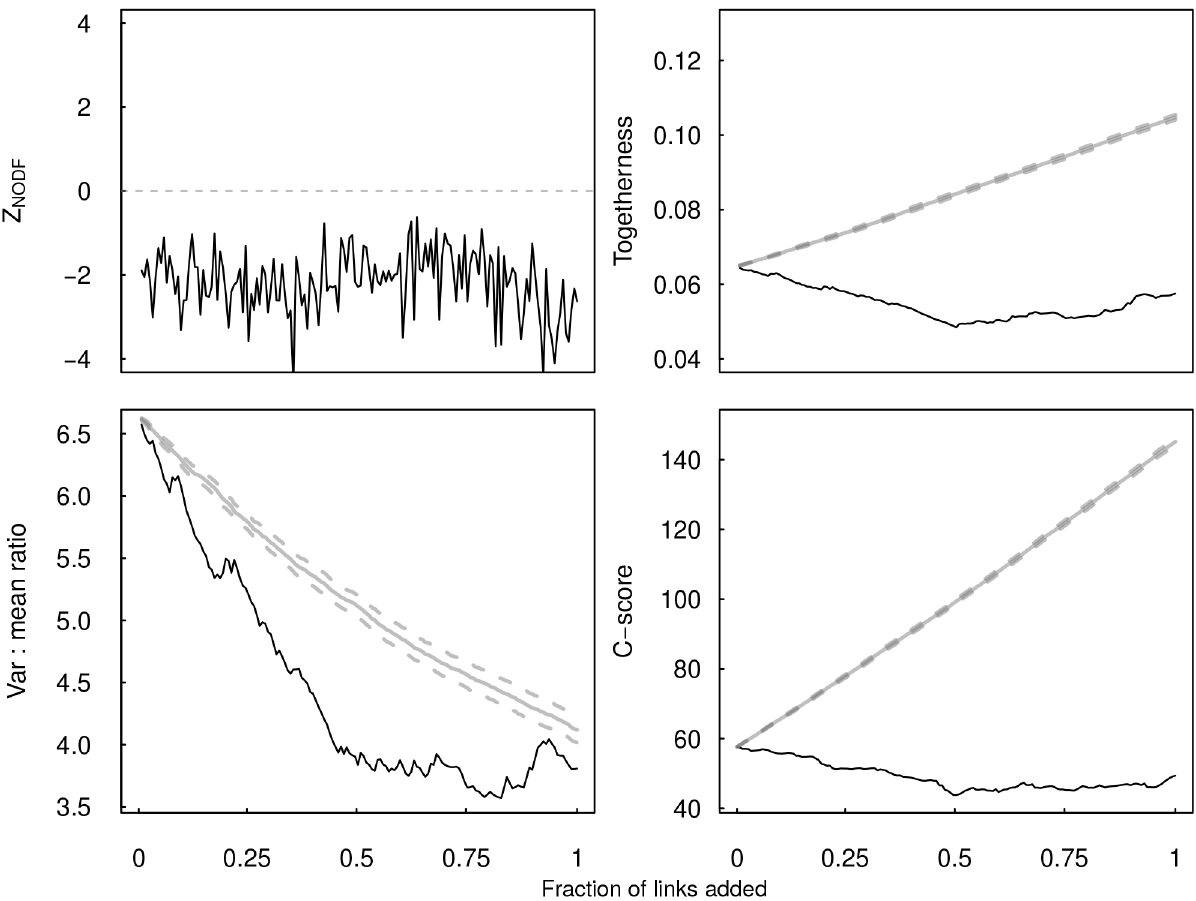
Fig 3. The sequential addition of the most likely missing links resulted in changes to severalnetwork properties relative to the change expected under random link addition (grey lines and dashed 95% confidence intervals). Specifically, the ability to detect nestedness ( a ) fluctuated with link addition.Other patterns showeda much strongerdirectionalsignal, including reductionsin togetherness, variance-to-mean ratio, and C -score. Each of these metrics describespatterns of (dis)aggegration in node degree, suggestingthat the fundamental organization of the network changeswith the additionof potentially missing